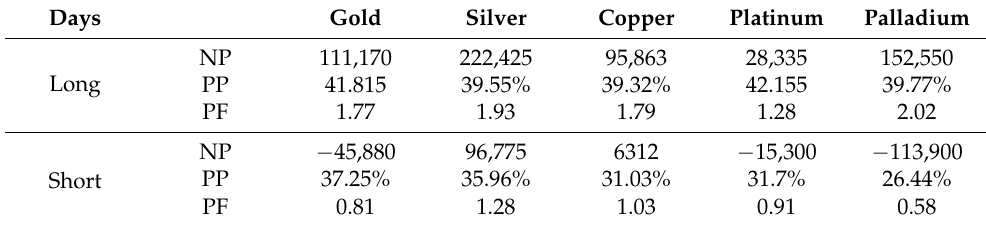
Table 6. Darvas boxes trading results of long/short strategies. Days